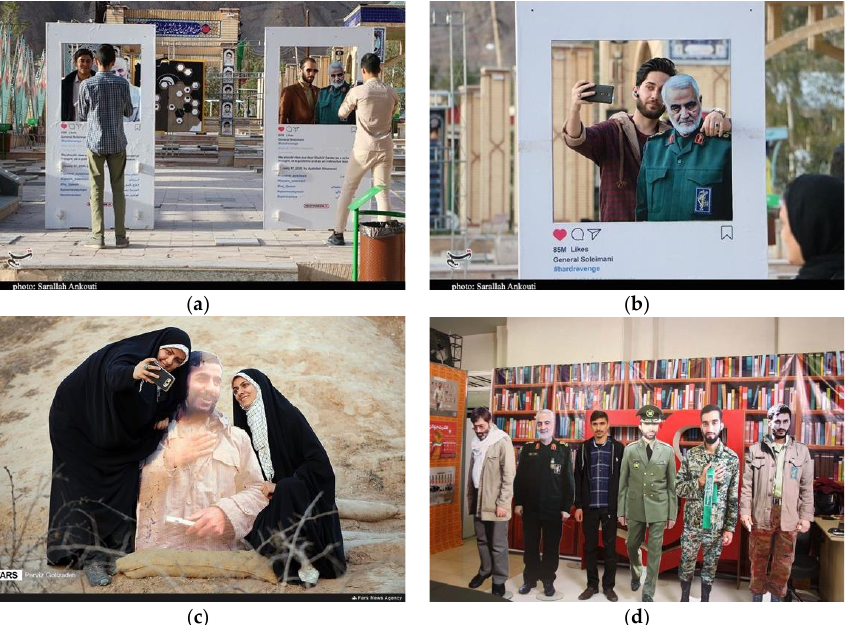
Figure 3. Selfie taking with martyrs’ cut-outs: ( a ) Instagram stands located at the burial site of Ghassem Soleimani. Source: Tasnim News; ( b ) A young man taking selfie with the cut-out of Ghassem Soleimani at his burial place, while putting his arm on the martyr’s shoulder. Source: Tasnim News; ( c ) Female visitors taking selfies with a martyr cut-out in the southeast of Iran on their visit to former war zones of the Iran-Iraq War. Source: Farsnews; ( d ) A young man (third from the left) standing among the cut-outs of martyrs in Tehran Book Fair. Source: Navid-e Shahed. The cut-out of Ghassem Soleimani was once placed on his burial site in the city of Kerman, printed on a stand and framed in the iconic graphic design of Instagram interface, according to an illustrated report by Tasnim News in 2020 (Figure 3a,b). 31 The negative space inside the framework was cut out in order for visitors to stand beside the image of the martyr and take photographs with him. The Like icon under the image counts 85 million times of likes, which amounts to the round number of the total population of Iran. The hashtag underneath reads #hardrevenge, which was the motto utilized by IRGC commanders a gainst the US after Soleimani’s assassination. The caption is a quotation from Ayatollah Khamenei translated in English: “We should view our dear Shahid Sardar (mar- tyred General) as a school of thought, as a guideline and as an instructive lesson. ” In this case, the aesthetics of Instagram platform and the practice of smartphone photography are integrated into the rituals of visiting the sacred site dedicated to Ghassem Soleimani.